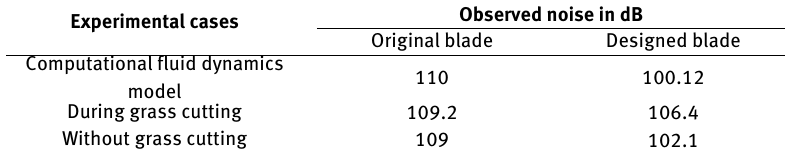
Table 3: Observed noise level at close range through both blades